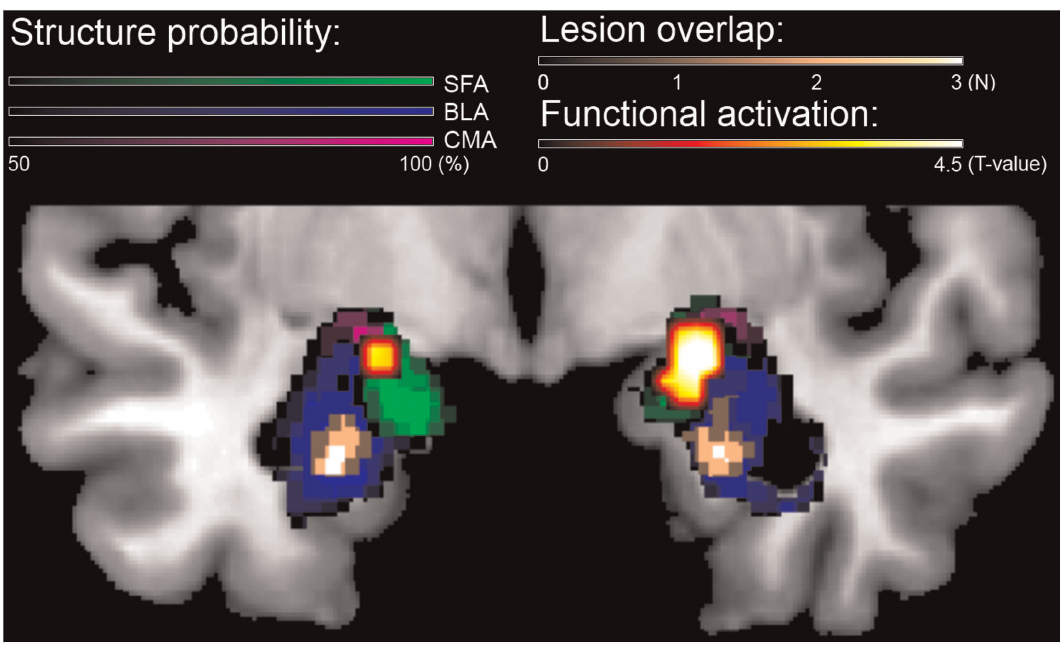
Figure 3. Structural and functional assessment of the bilateral amygdala in our group of three Urbach-Wiethe Disease subjects. Plotted are the cytoarchitectonic probability-maps of the amygdalae thresholded at 50%, structural lesion overlap, and functional activation during the emotion-matching task (contrast: Emotion . Shape matching, significant clusters p , .05, FDR-corrected for paired samples t-tests within ROI’s analysed separately for each hemisphere) on a template brain. The structural method indicates that the lesions of the three UWD subjects are located in the basolateral amygdala (BLA), while the functional method shows activation during emotion matching in the superficial amygdala (SFA) and central-medial amygdala (CMA), but not in the BLA.